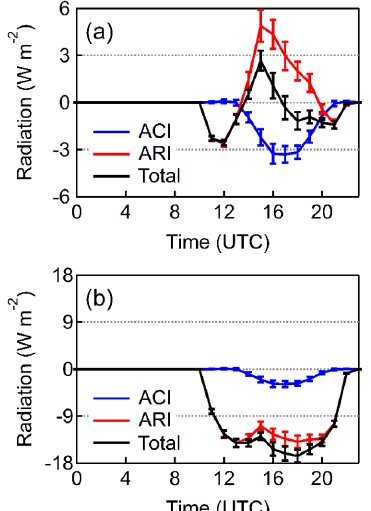
Figure 3. Diurnal variation in changes in all-sky shortwave radia- tion at (a) TOA and (b) surface in the EMIS1 emission scenario. Error bars denote the standard